Question: Produce a descriptive caption suitable for publication.
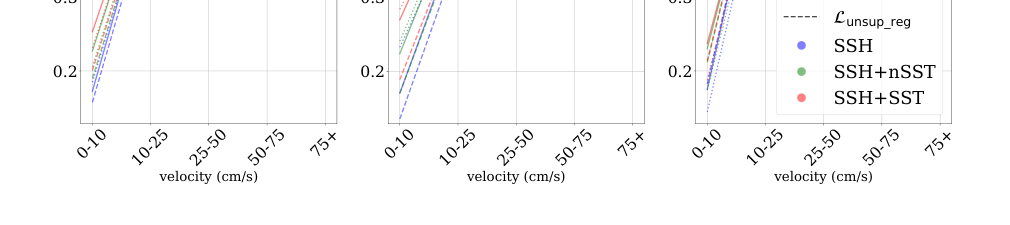
Answer: Detection scores of the different methods on eddies separated by radius (first row),